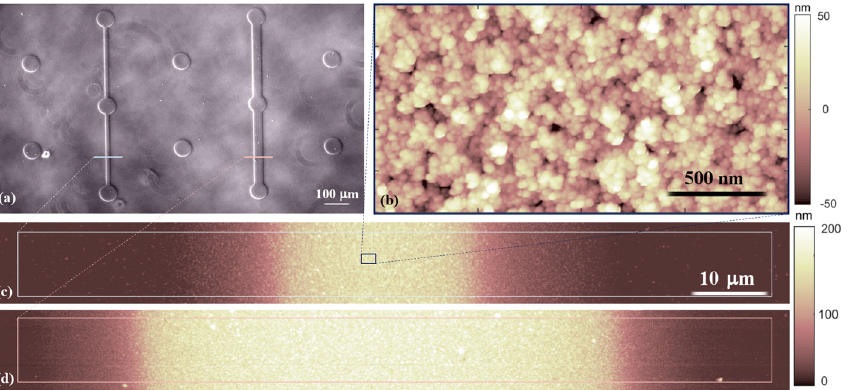
Figure 1. ( a ) Image of the micrometric nanostructured pattern of zirconia acquired using an optical microscope. Morphological maps of the nanostructured zirconia acquired via atomic force microscopy (AFM) in the homogeneous film ( b ), characterised by 15 nm surface roughness and sections of the bridges (20 and 50 μ m large) connecting different islands ( c , d ).